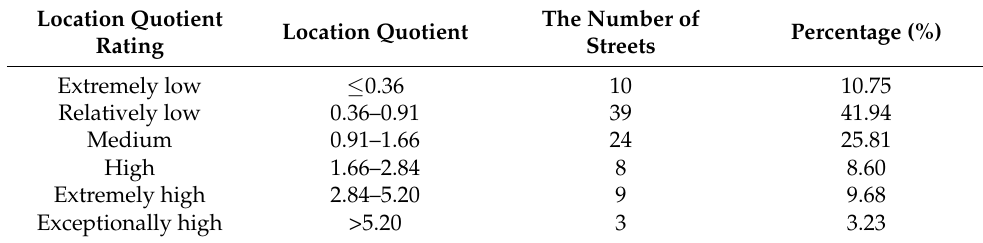
Table 2. Number and proportion of streets graded based on location quotient of the elderly